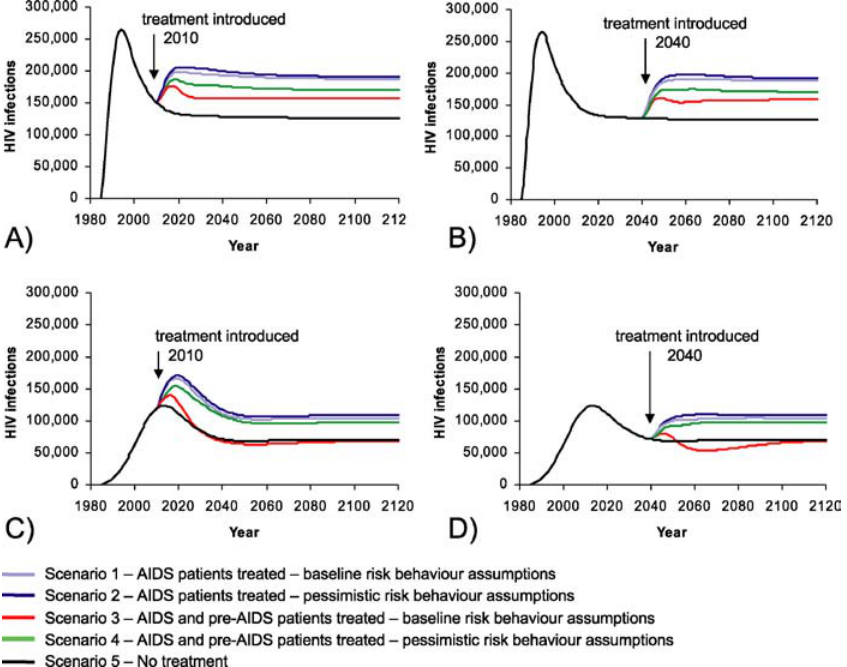
Figure 2. Total Number of HIV Infections through Time for Various HIV Epidemics and under Different Assumptions regarding Behaviour Change of Treated Patients (A) and (B) illustrate a high prevalence, mature epidemic, similar to that of Malawi; (C) and (D) a smaller-scale epidemic (partner change rates one-third of those for the Malawi simulation). (A) and (C) introduce ART in 2010, before equilibrium for (A) and early in the epidemic for (C); (B) and (D) introduce ART in 2040, once equilibrium is reached for (B) and after the peak of the epidemic for (D). For each HIV epidemic scenario graph, two treatment options and two behaviour change scenarios are illustrated: (1) treatment of AIDS patients only, baseline behaviour change assumptions (Table 3); (2) treatment of AIDS patients only, pessimistic behaviour change assumptions (Table 3); (3) treatment of AIDS and pre-AIDS patients, baseline behaviour change assumptions; (4) treatment of AIDS and pre-AIDS patients, pessimistic behaviour change assumptions. DOI: